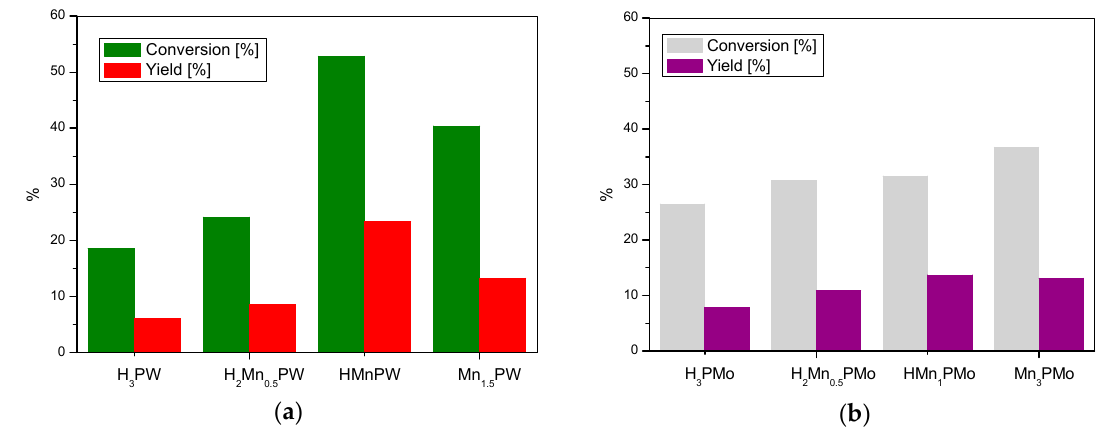
Figure 3. The BV oxidation of cyclohexanone with ( a ) iron tungstophosphate catalysts and ( b ) iron molybdophosphate catalysts.